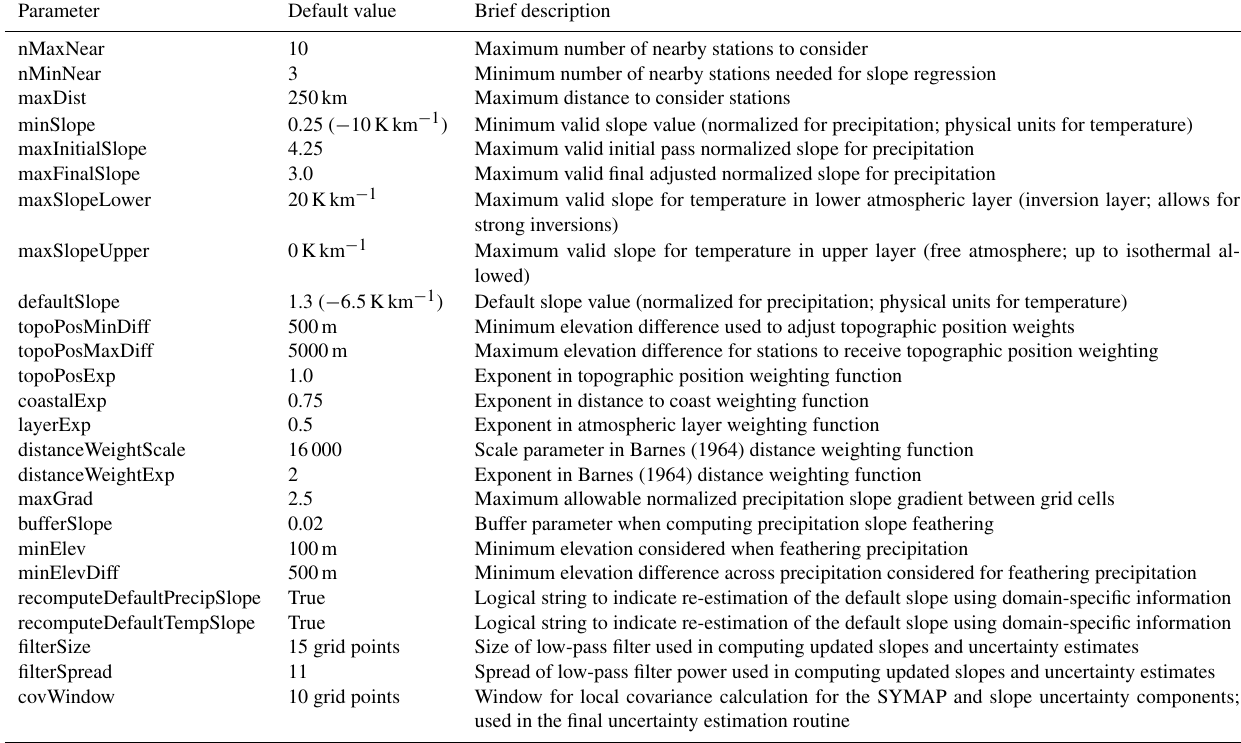
Table 3. TIER model parameters. Default values are given for precipitation with values for temperature given in parentheses. Parameter